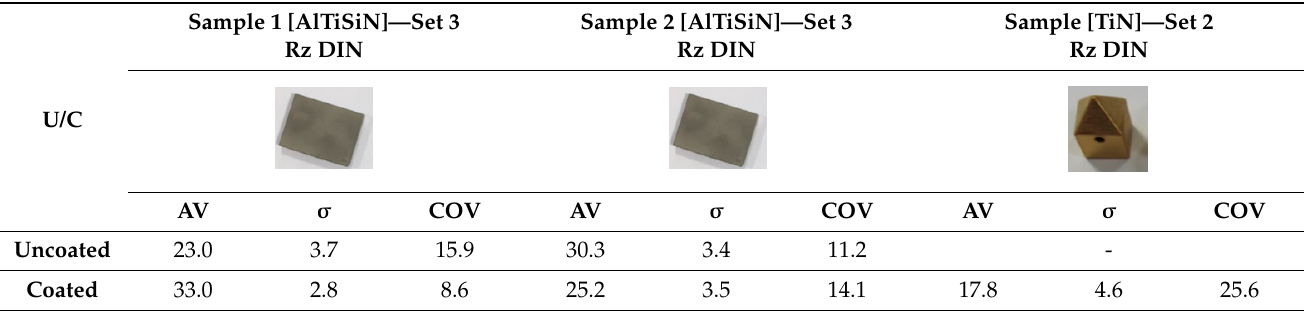
Table 6. Roughness values of samples (AV = Mean value; σ = standard deviation; COV = Coefficient of variation).